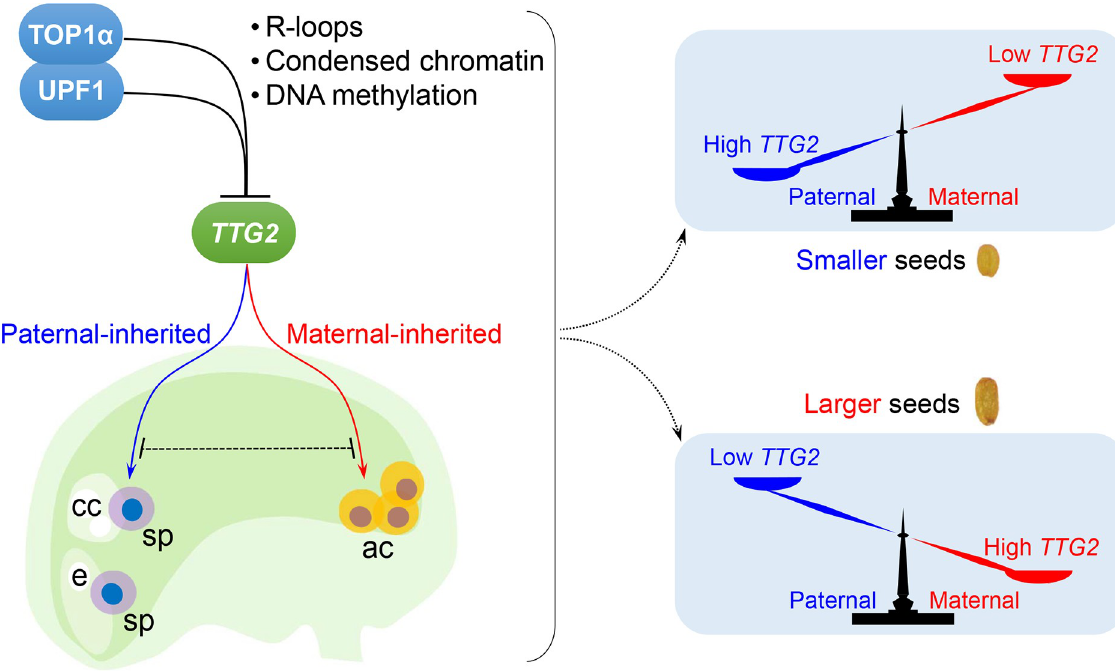
Fig 7. A model depicting the regulation of seed size by parental TTG2 dosage. TOP1 α interacts with UPF1, which facilitates their binding to the TTG2 locus. This binding compromises R-loops that hamper the chromatin condensation. Loss of TOP1 α and UPF1 makes the TTG2 locus more accessible with less GC-methylation, permitting a higher TTG2 expression. The repressive effects of TOP1 α and UPF1 on TTG2 exist in sperms from the pollen and in antipodal cells from the female gametophyte, whereas paternal-inherited and maternal-inherited TTG2 affect seed size in an opposite manner. The relative parental dosage of TTG2 determines the seed size so that an increase in maternal or paternal TTG2 results in larger or smaller seeds, respectively. ac, antipodal cells; cc, central cell; e, egg cell; sp, sperm.